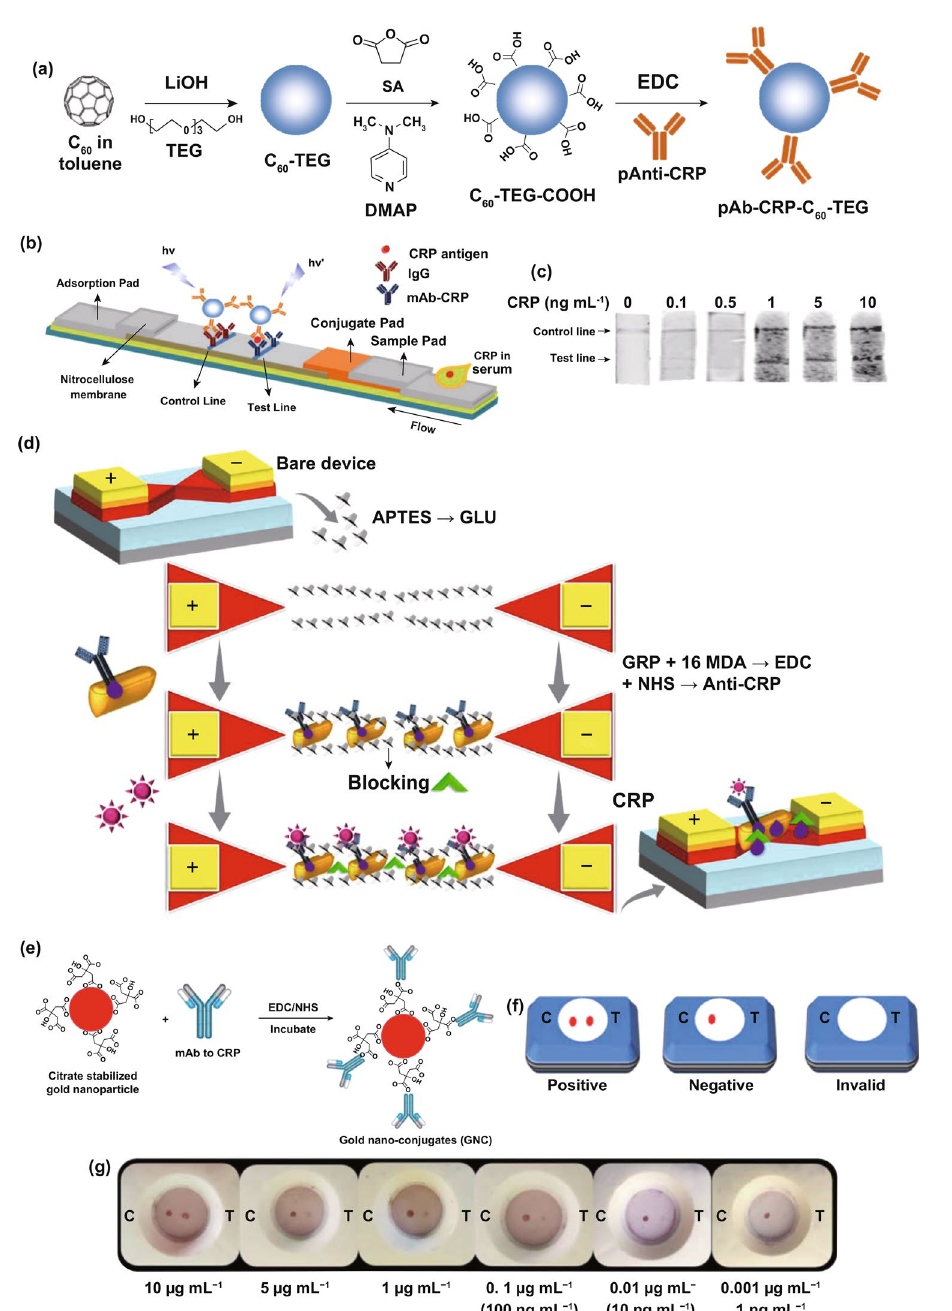
Fig. 7 Fluorescent C 60 nanoparticle-based lateral flow immunochromatographic platform for CRP detection. a Schematic illustration of the fab- rication of pAb-CRP-C60-TEG fluorescent nanoprobes. b Schematic drawing and operative procedures of the pAb-CRP-C60-TEG fluorescent nanoprobe-based lateral flow immunochromatographic platform to detect CRP. c The fluorescence images of the test strips with various concen- tration of CRP from 0.01 to 10 ng/mL. Reproduced with permission from Ref. [146]. Copyright 2019 Springer Nature. d Schematic diagram for GNR-integrated voltammetry detection of CRP. Reproduced with permission Ref. [147]. Copyright 2019 Elsevier. GNC probe-based ultrasensi- tive vertical flow immunokit (VFIK) for the rapid detection of CRP. e Rational design and synthesis of GNC probes. f Schematic illustration indicating the prospective results presented by GNC-VFIK. g Test performance of GNC-VFIK with different concentrations of CRP in analytes. Reproduced with permission from Ref. [148]. Copyright 2020 Springer